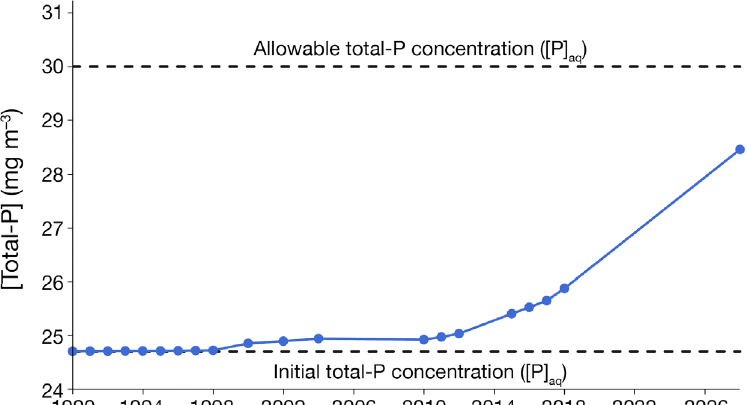
Fig. 6. Predicted changes in total-P concentrations in Lake Kariba, based on historical and predicted P loads from aquaculture. Dashed lines indicate the initial ([P] i ) and allowable ([P] aq ) total-P